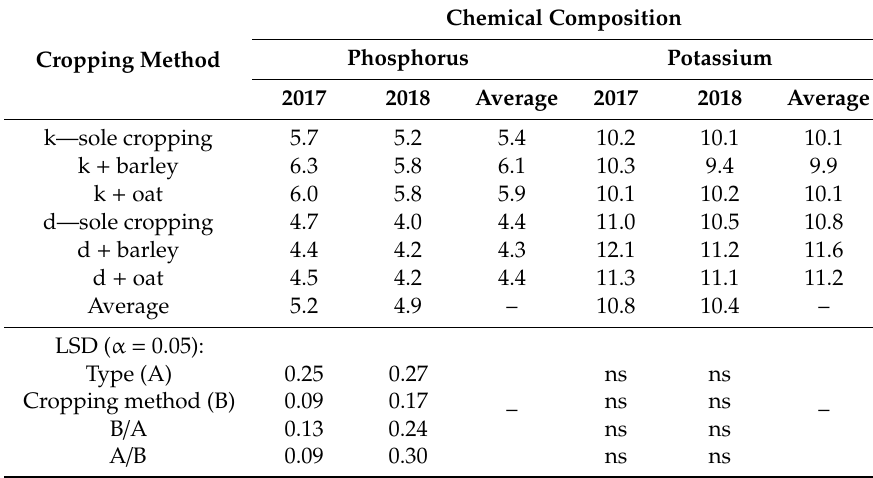
Table 8. Concentrations of phosphorus and potassium (g · kg − 1 ) in chickpea seeds, depending on cropping method and type (k—kabuli; d—desi; ns—not significant at Tukey’s test P ≤ 0.05).